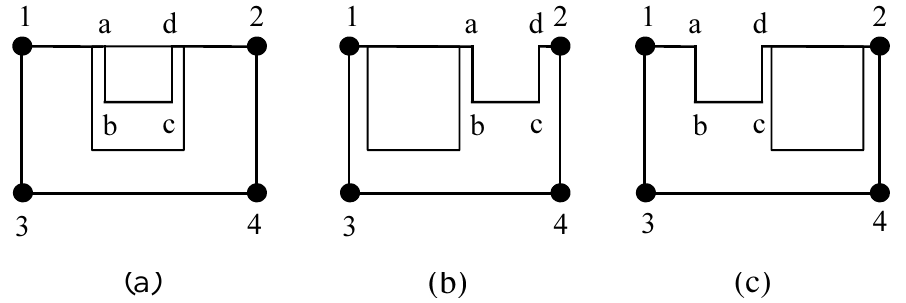
Figure 10. ( a ) A label that can be assigned to more than one segment of the same edge. In ( b , c ) we show the two edge segments that the label can be placed.